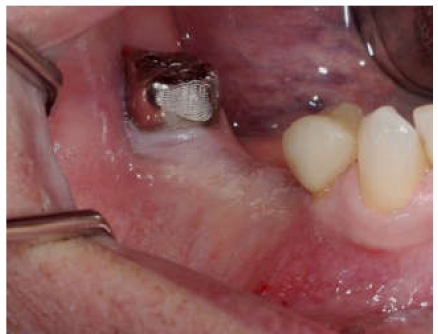
Figure 2. Pre-operative clinical aspect of the narrow residual